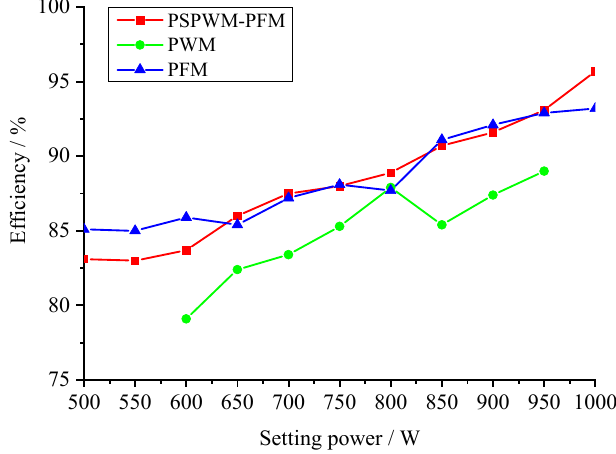
Figure 22. Efficiency curve.